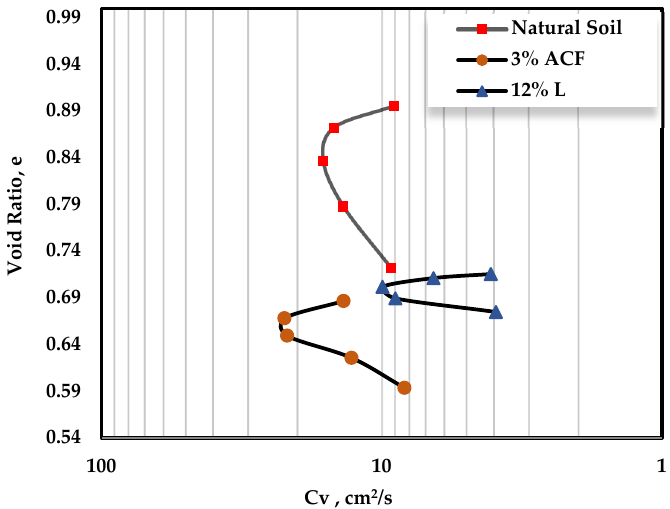
Figure 10. Consolidation coefficient.